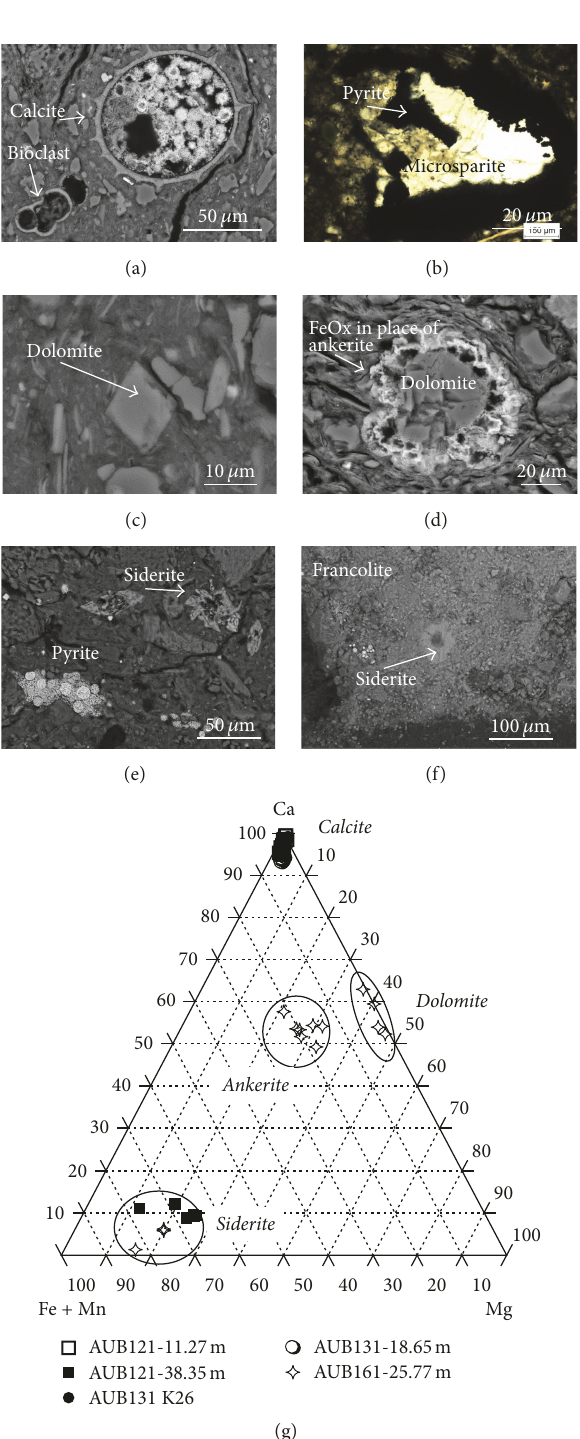
Figure 4: (a) Calcite bioclast filled by framboidal pyrite which is partially oxidized (AUB1010-6.63 m) (BSE image); (b) residual porosity in bioclast filled by microsparite (AUB1010-11.32 m) (transmitted light); (c) euhedral grain of dolomite (BSE image) (AUB1010-6.63 m); (d) grain of Fe-bearing dolomite partially dissolved and surrounded by iron hydroxides (BSE image) (AUB1010-4.80 m); (e) cluster of siderite grains (AUB1010-16.1m); (f) isolated siderite grain enclosed in diagenetic phosphate nodule (AUB131-38 m); (g) electron microprobe analyses of carbonates in thin sections of